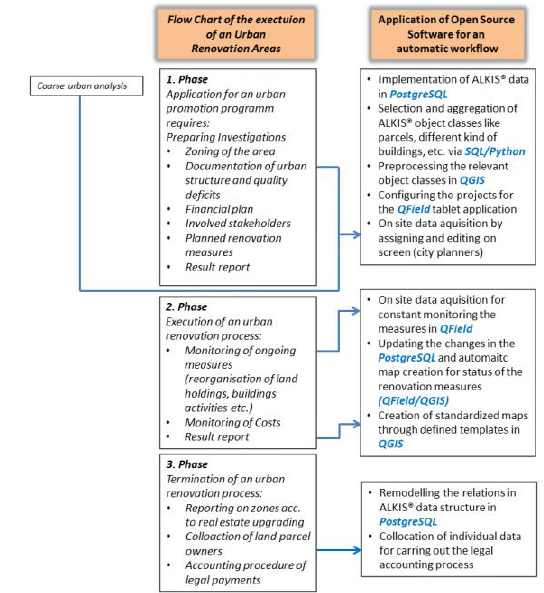
Figure 1: Legal process of the realization of a renovation area with the corresponding open-source